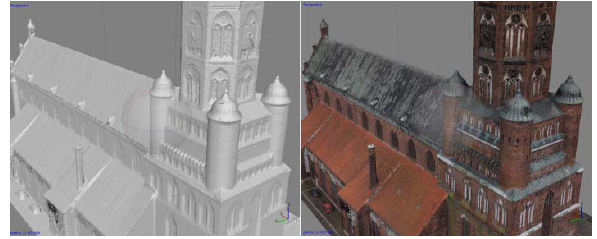
Figure 8. Model of the naves without and with fotorealistic texturing (AgiSoft, 11.5 Mio. Points)